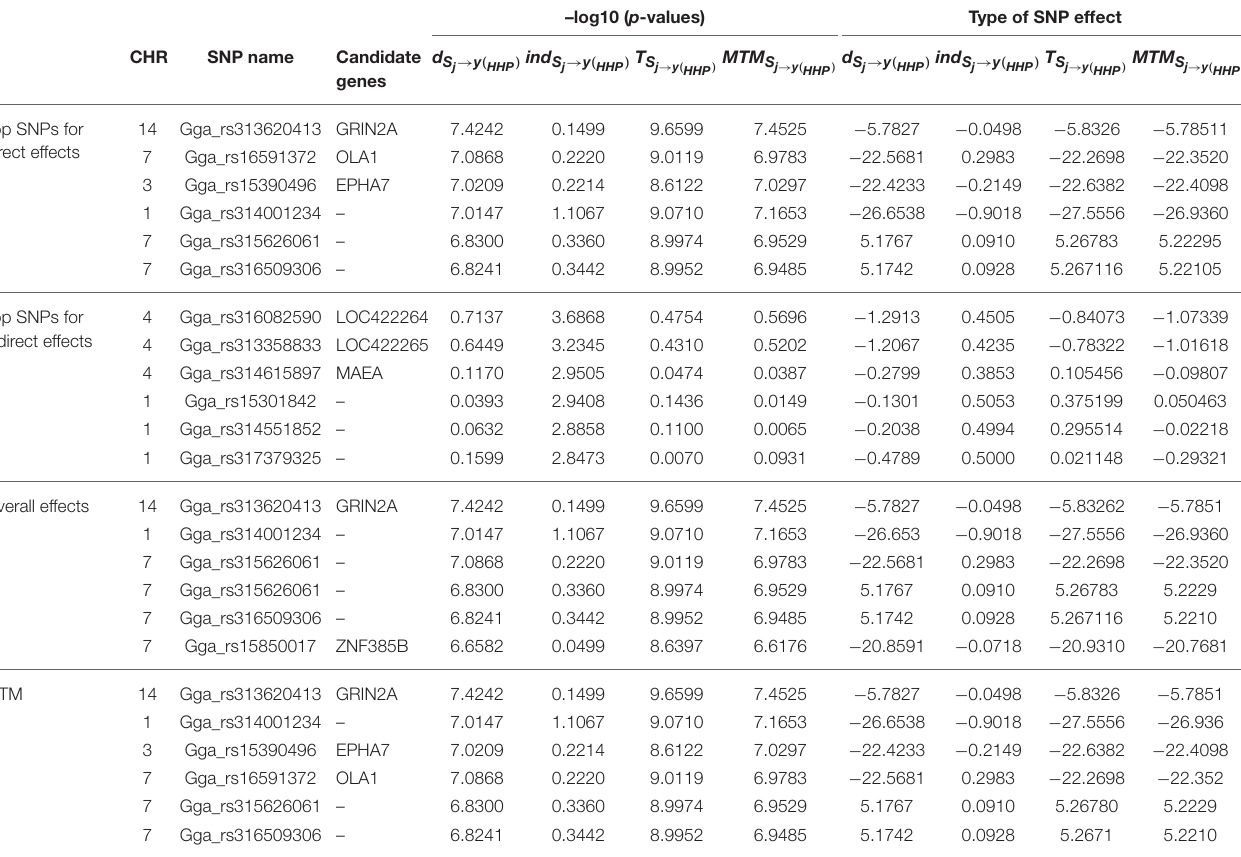
TABLE 3 | Six most significant SNPs selected according –log 10 ( p -values) and their effects, using the full recursive SEM (SEM-A75) and MTM